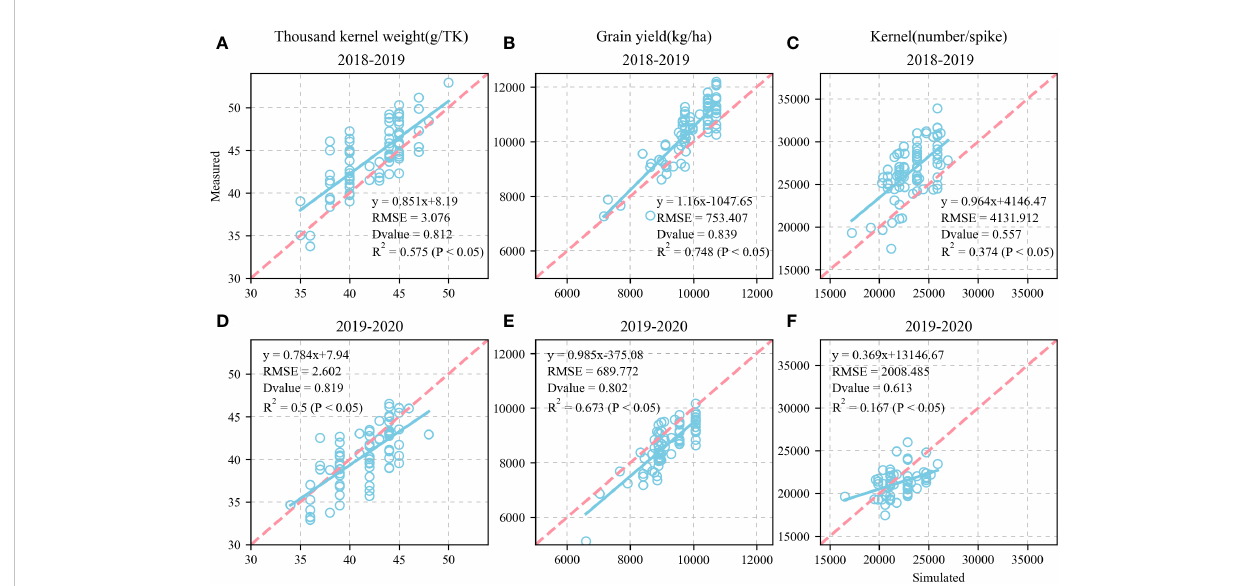
FIGURE 9 Calibration and evaluation of APSIM-Wheat model for modelling thousand-kernel weight (TKW), grain yield (GY) and kernel number (KN) and (1:1, dashed line) of 81 wheat varieties at Xinxing station for calibration dataset (2018-2019) and evaluation dataset (2019-2020) (1:1, dashed line). Comparison of observed and simulated thousand-kernel weight (TKW) (A) , grain yield (GY) (B) , and kernel number (KN) (C) for calibration datasets. Comparison of observed and simulated thousand-kernel weight (TKW) (D) , grain yield (GY) (E) , and kernel number (KN) (F) for evaluation datasets.